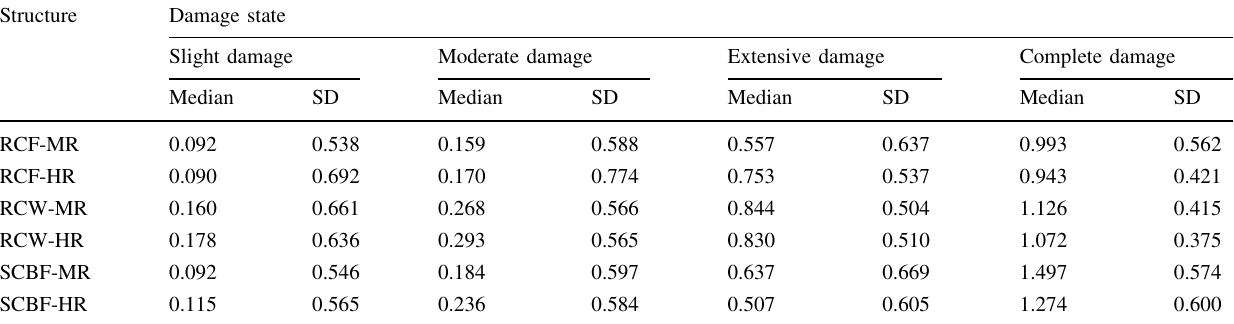
Table 5 Parameters of the fragility functions (median and standard deviation) for the generic structural typologies in Bucharest, Romania